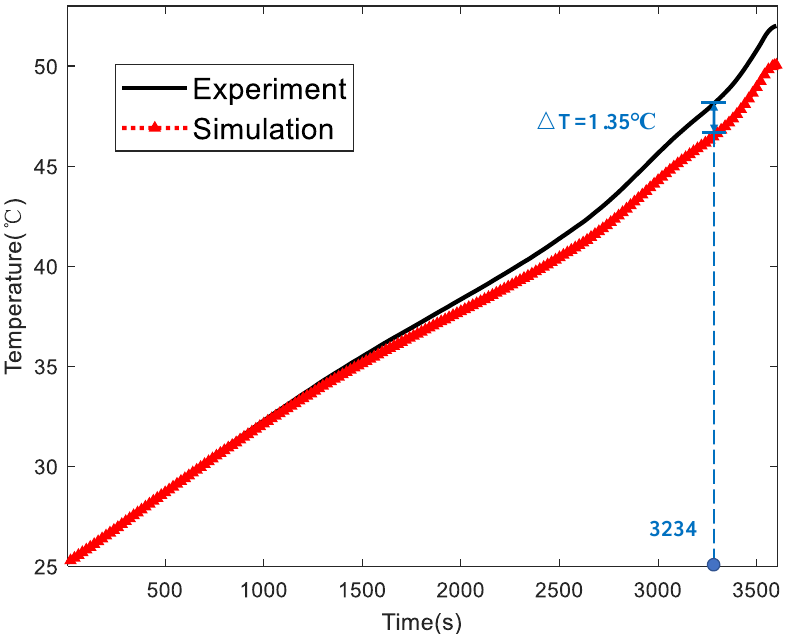
Figure 5. Comparison between simulated temperature data and actual temperature data for 1C discharge. Table 3 . CFD calculation parameters.